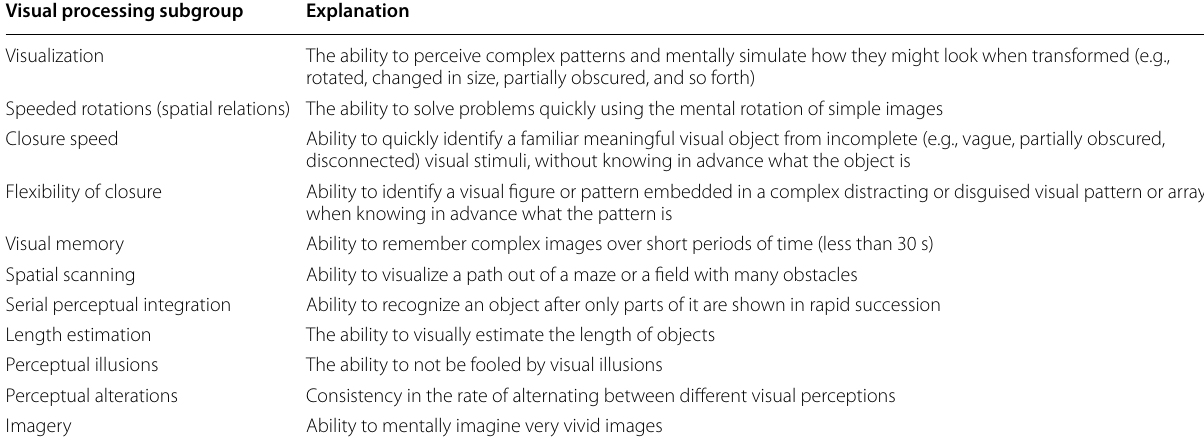
Table 3 Cattell–Horn–Carroll (CHC) explanation Visual processing